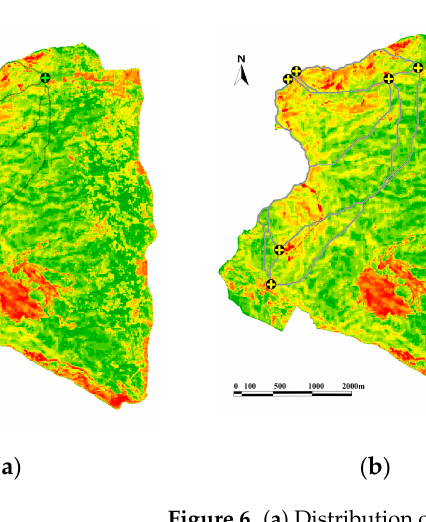
Figure 6. ( a ) Distribution of the core landscape-dissemination paths, ( b ) distribution of the secondary landscape-dissemination paths, and ( c ) landscape patterns of Tianmeng Mountain Scenic Spot. The background graph shows ecological-resistance value, the color from green to red represents increasing ecological resistance, which means that migration is becoming more difficult.